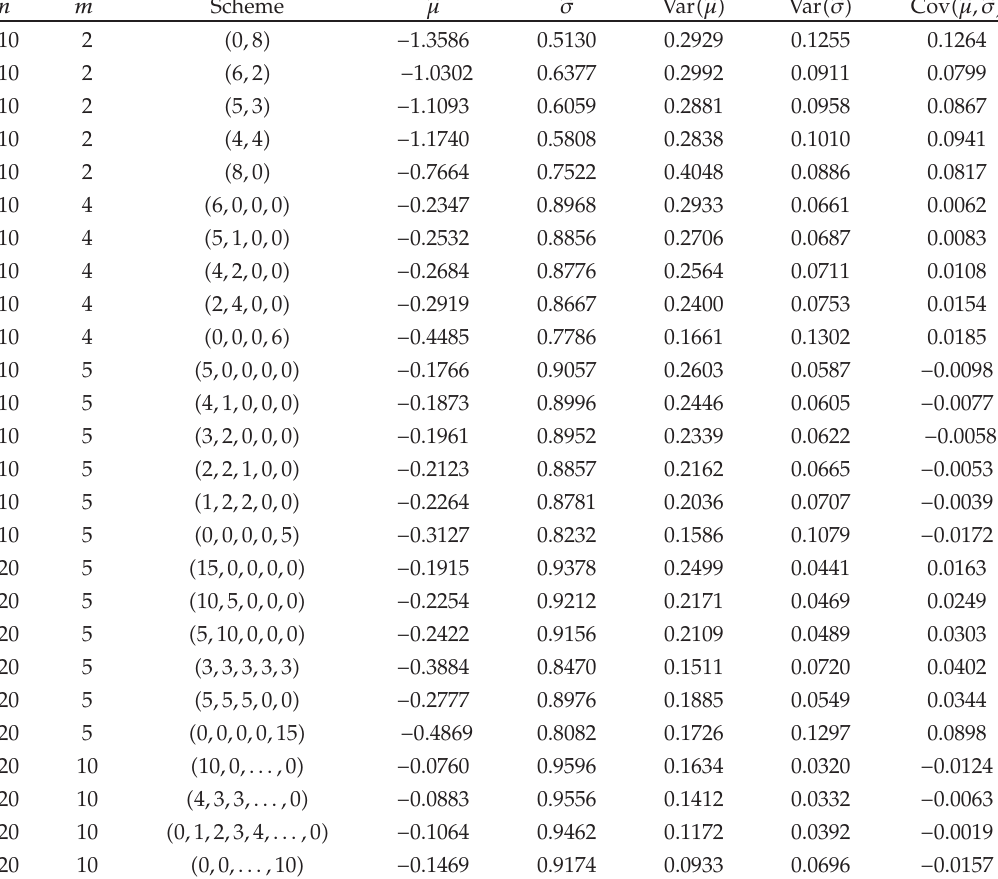
Table 6: Average, variances, and covariance of the MLEs when the shape parameter φ (cid:7)